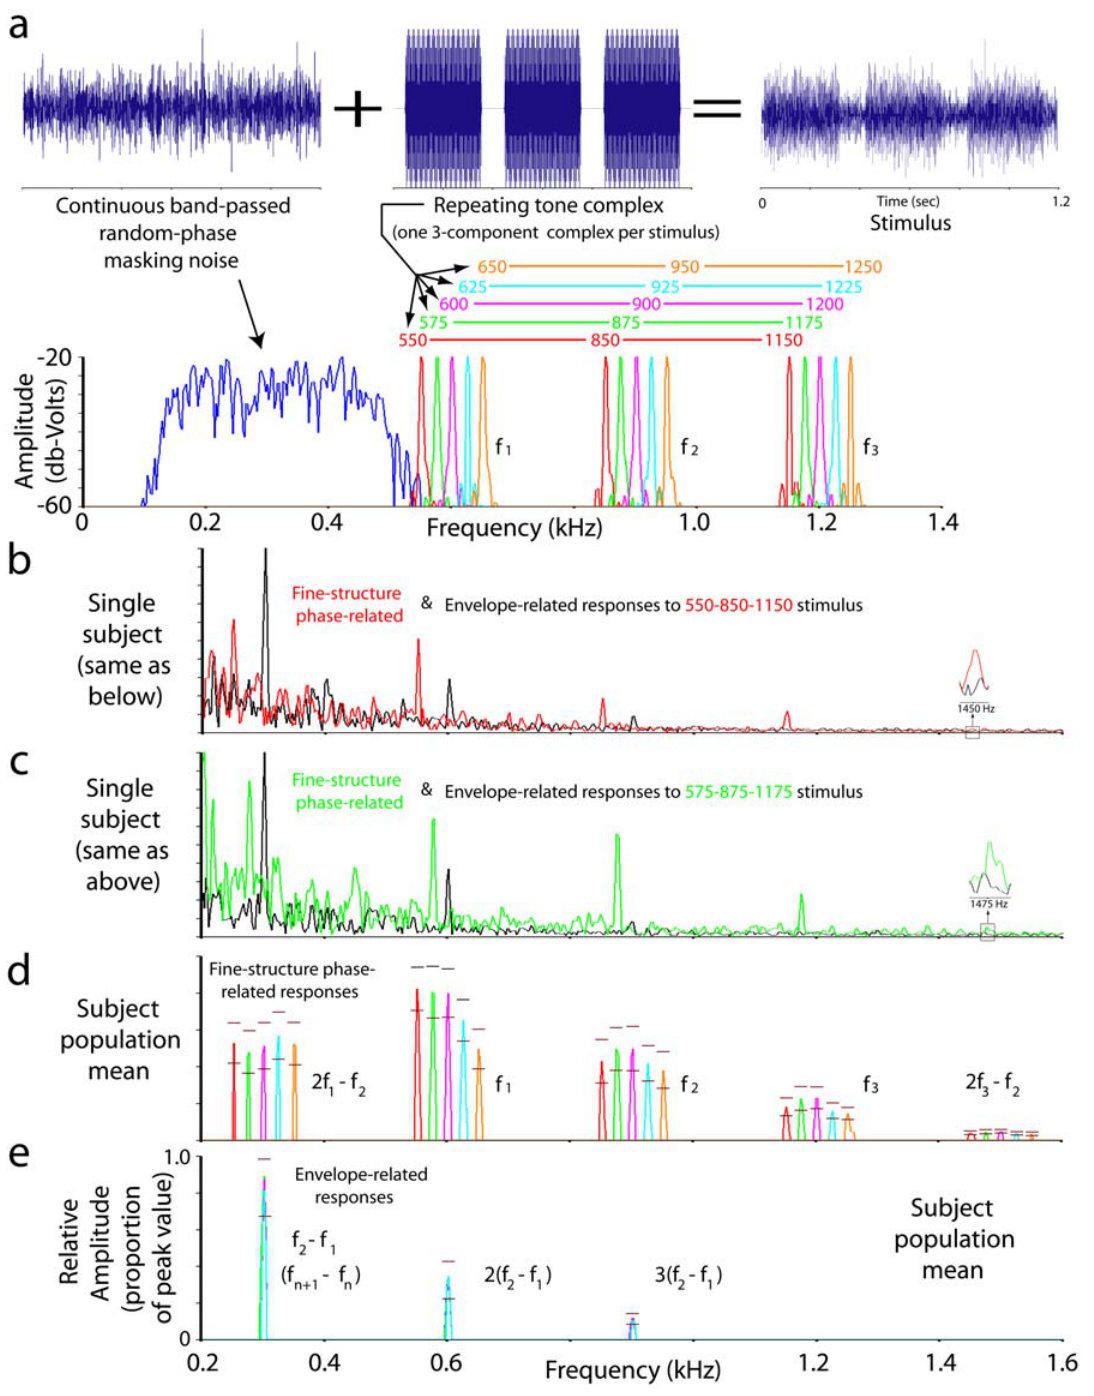
Figure 2. Stimulus design and evoked potential responses. (a) Amplitude-time waveforms showing stimulus construction by adding band-passed, random phase noise (top, left) to repeating 3-note tone complexes (top, center) to produce the stimuli used in perceptual testing and for evoked- potential recording. There were five different tone complexes used; each is shown color-coded above its constituent components on an amplitude– frequency plot (bottom), where the components of each tone are overlaid on a common set of axes. (b,c) Amplitude spectra of the evoked potential responses from a single subject for two of the stimulus tones. The sum of the 0 u and 180 u responses is shown in black (envelope-related), and the difference of the 0 u and 180 u responses is shown in red or green (fine-structure phase-related). The y-axis is in units of relative amplitude; the corresponding measured values for the highest y-axis marker are 0.38 m V (black) and 0.35 m V (red) for Figure 2b, and 0.26 m V (black) and 0.23 m V (green) for Figure 2c. Colors refer to Figure 2a. (d,e) Mean relative amplitude spectra (n=22 subjects) of peaks in the fine-structure-related (difference, Figure 2d) and envelope-related (sum, Figure 2e) evoked potential responses, all of which passed criteria for robustness (see Methods). Responses to each stimulus tone have been overlaid on the same set of axes. Colors refer to Figure 2a. Error bars represent 95% confidence intervals around the mean value.